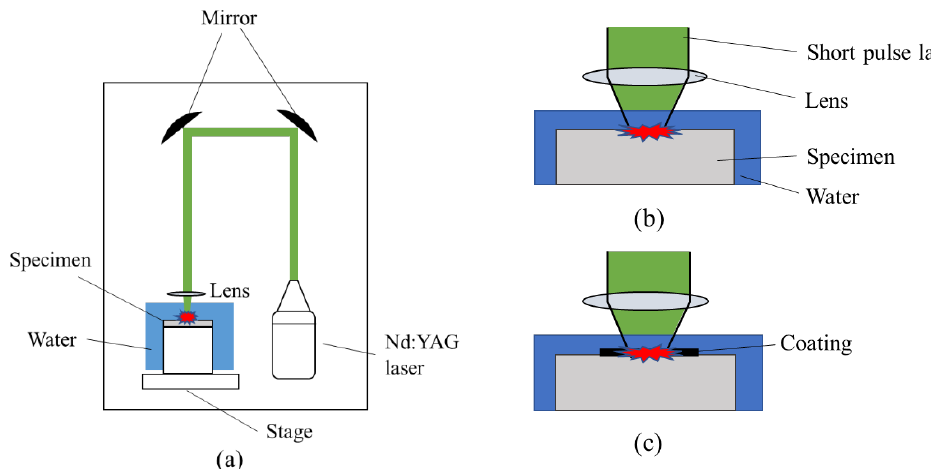
Figure 2. ( a ) Schematic of laser peening (LP) processes; ( b ) LP without coating (LPwC); ( c ) LP with coating (LPC).